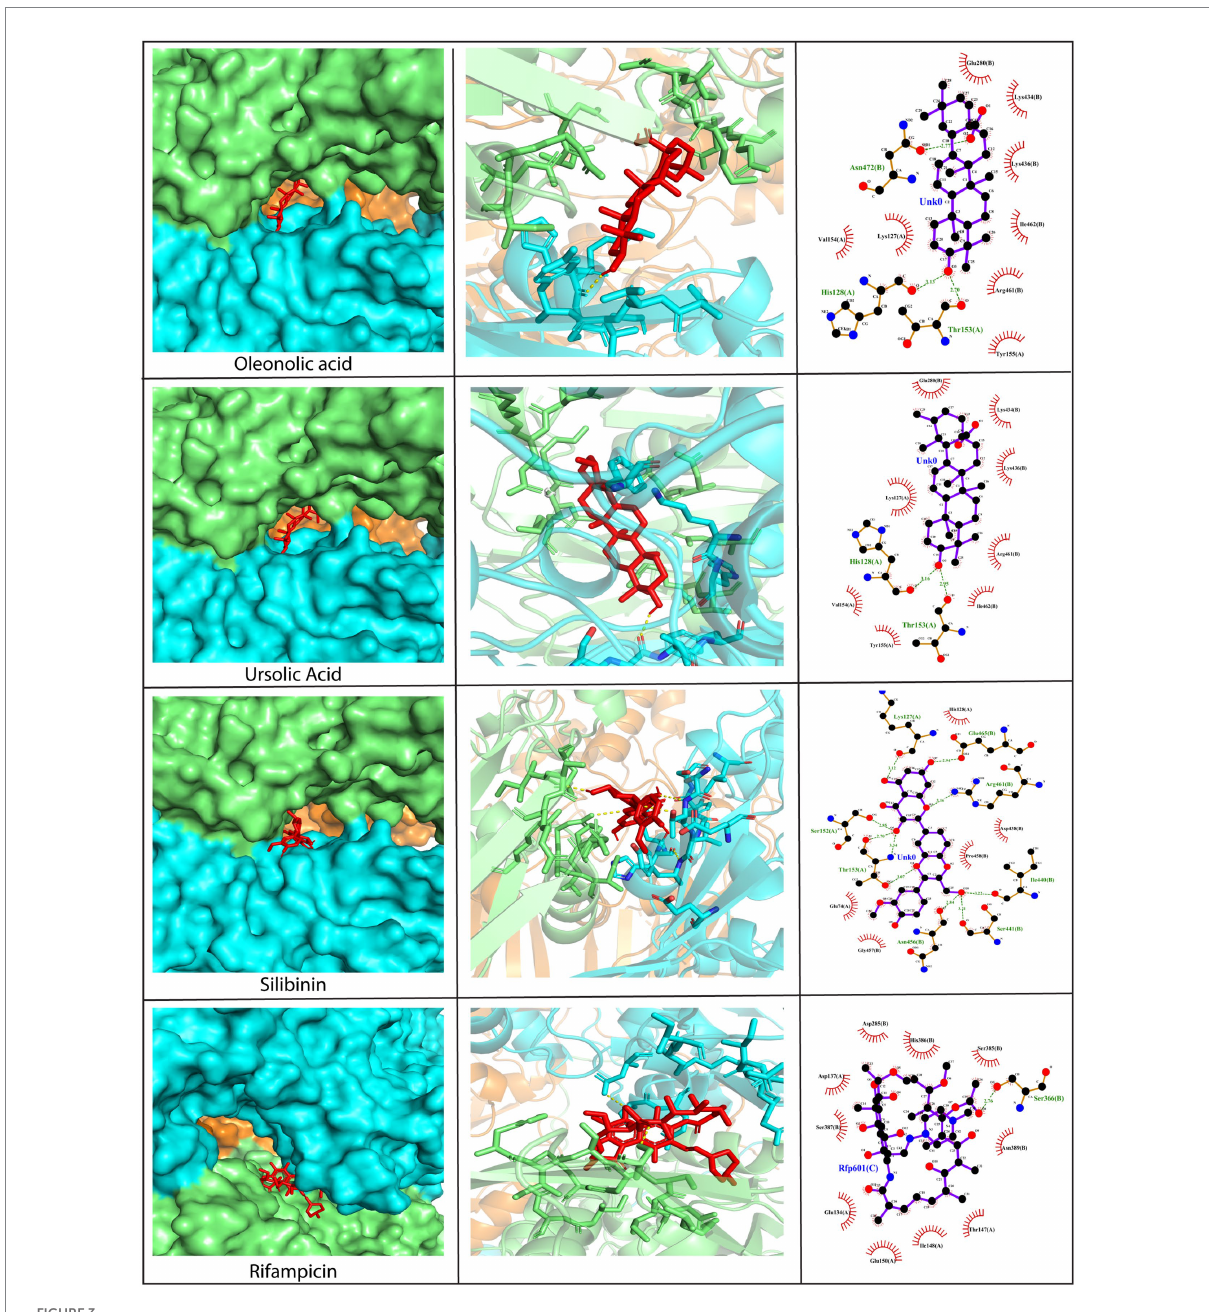
FIGURE 3 Molecular docking of silibinin, oleanolic acid, and ursolic acid against the D13 protein (PDB ID: 6BED). Left Panel: Visualization of the binding position of the ligand within the protein cavity. Central Panel: Ribbon diagram showing the docked complex. Ligands have been shown in red. Right Panel: 2D diagram representing the interactions between the phytochemicals and D13 protein generated by LigPlot. Dashed lines show hydrogen bonds while the red arcs represent hydrophobic interactions. Rifampicin has been used as a control. Docking was performed via AutoDock Vina (Version 1.5.7) and the 3D structures were visualized using PyMol